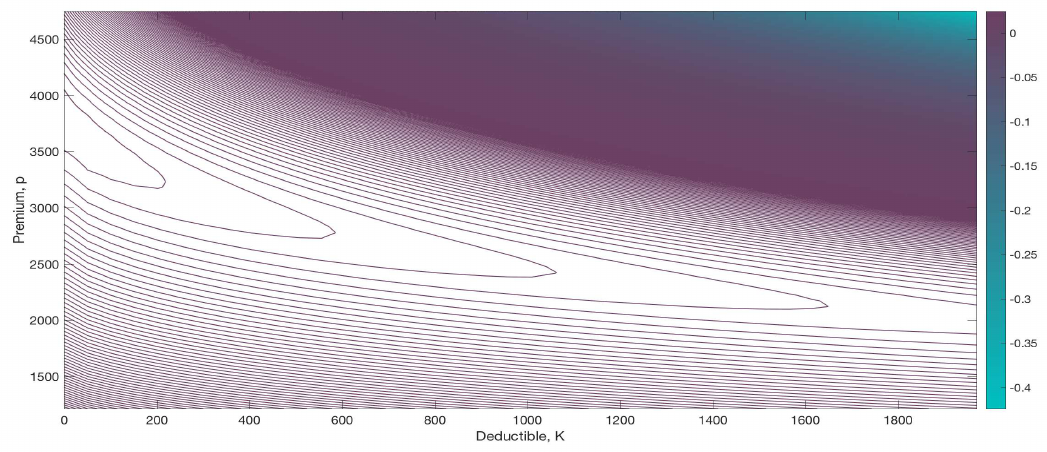
Figure 3. A contour of the relation µ ( p ; K ) / σ ( p ; K ) 2 for deductibles in the range [ 0,2000 ] and premiums in [ 1210,4750 ] .